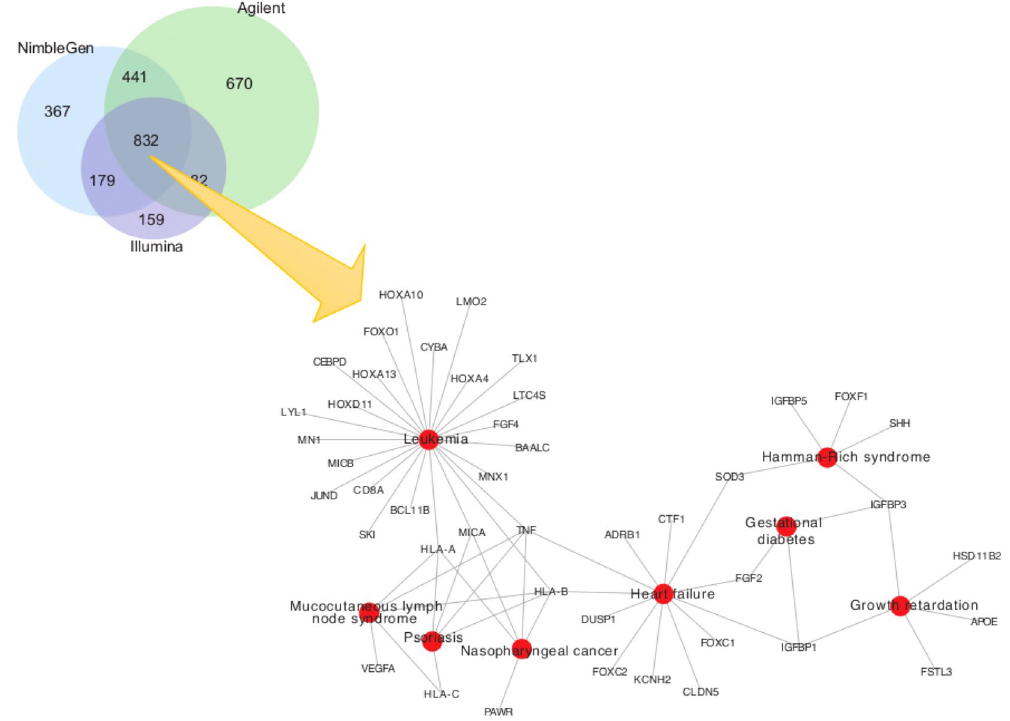
Figure 7. Genes with low coverage in three different datasets. ( A ) Venn diagram showing number of low coverage genes (CCS score > 0.2) across three different platforms. There are 832 genes with low coverage in common across all platforms. ( B ) Network diagram showing disease ontology analysis of the 832 low-coverage genes showing associations with leukemia, psoriasis, heart failure, and mucocutaneous lymph node